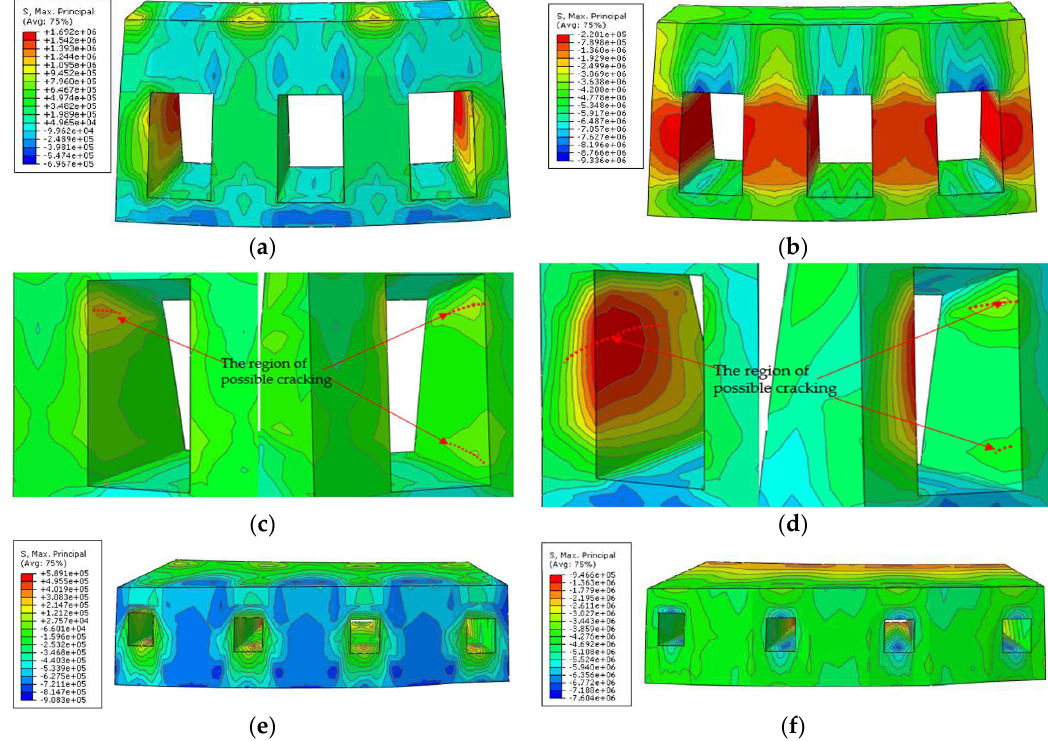
Figure 8. The first and third principal stress distribution and possible cracking positions of outlets under analysis case (Unit: Pa). ( a ) The first principal stress distribution of upper outlets; ( b ) the third principal stress distribution of upper outlets; ( c ) possible crack positions of the middle upper outlet; ( d ) possible crack positions of the side upper outlet; ( e ) the first principal stress distribution of middle outlets; ( f ) the third principal stress distribution of middle outlets.